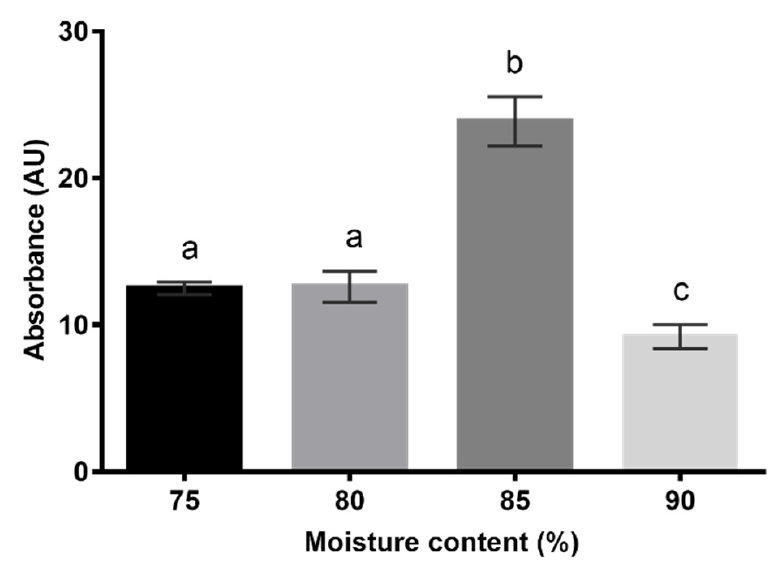
Figure 4. Evaluation of moisture content (% w/w ) for solid-state fermentation using an inert support, and the culture medium A. Values are the mean ± SD ( n = 3). Statistical analysis was performed by one-way ANOVA. Bars with different letters are significantly different ( p < 0.05) while the same letter indicates no statistical difference.